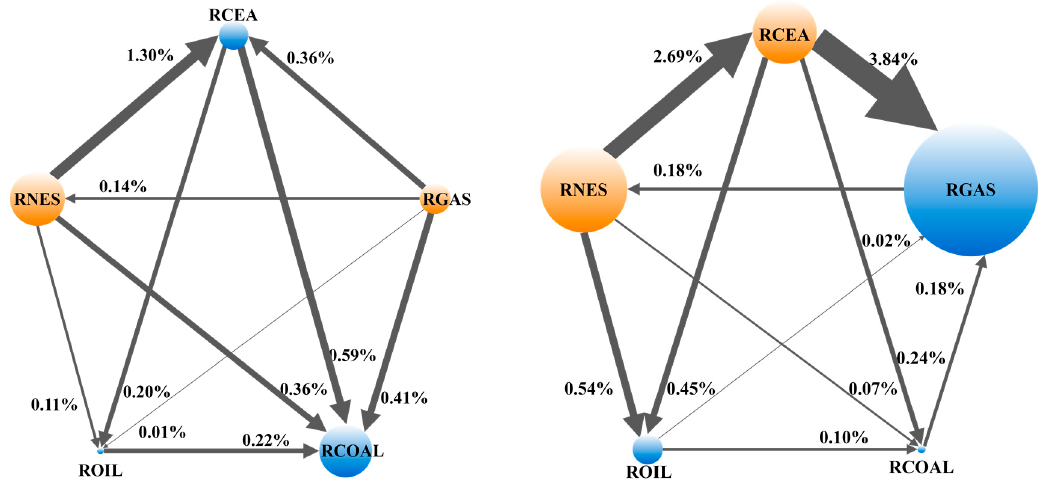
Figure 3. The pairwise connectedness of the carbon trading market, new energy stock market, and fossil energy market in the positive return and negative return system. The color of the node in the figure represents whether it is a net transmitter or a net receiver. Net transmitters are shown in orange and net receivers are shown in blue. The size of the node shows the value of the net spillover; the larger the node, the larger the value of the net spillover. The thickness of the arrow line indicates the degree of information spillover; the thicker the line, the higher the degree of spillover between markets.